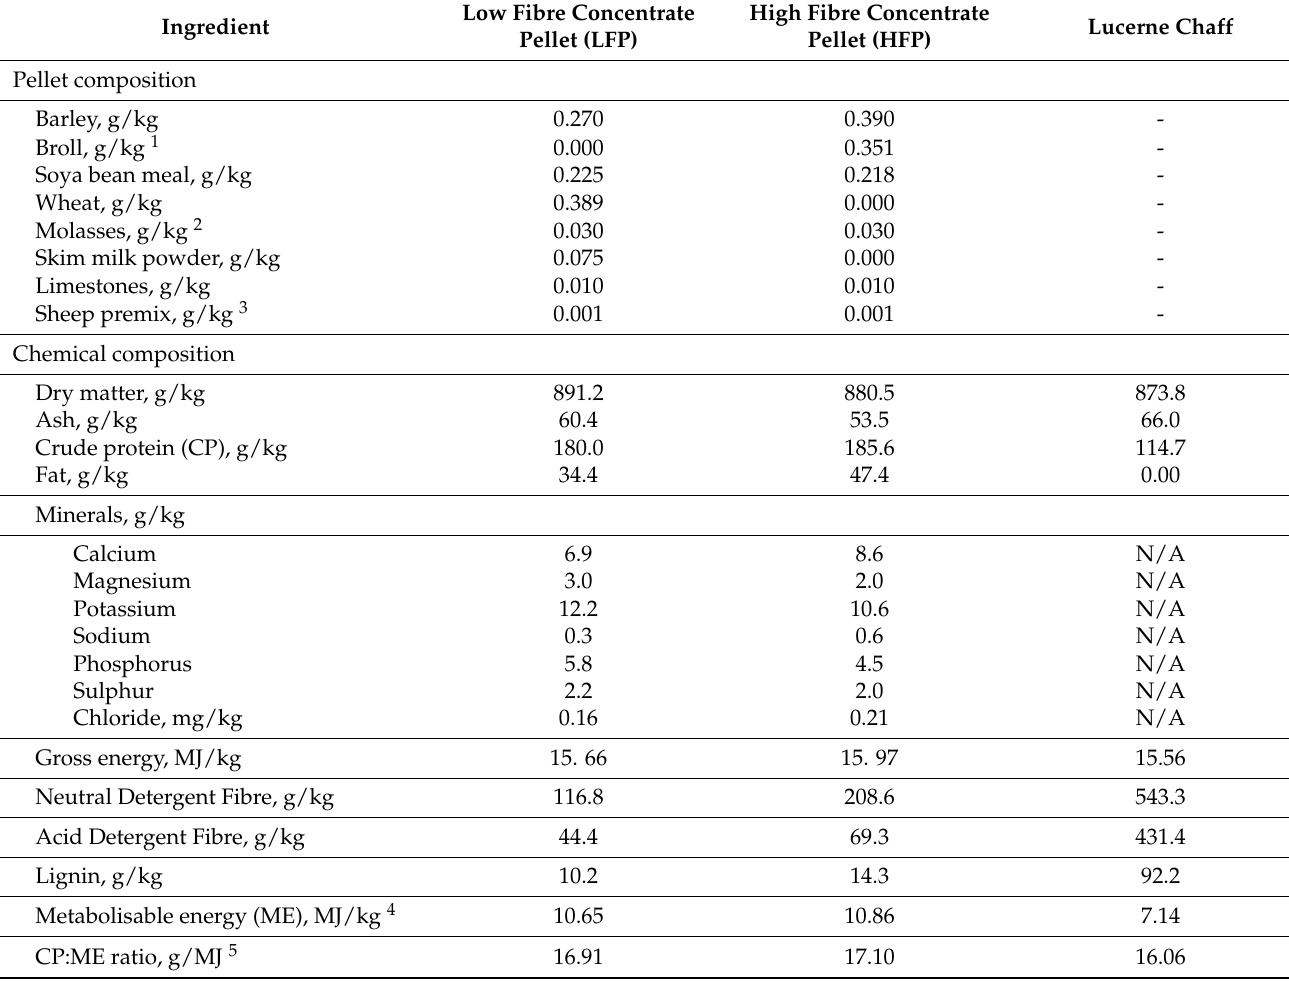
Table 2. Pellet composition and chemical analysis of pellets and lucerne chaff in fresh matter